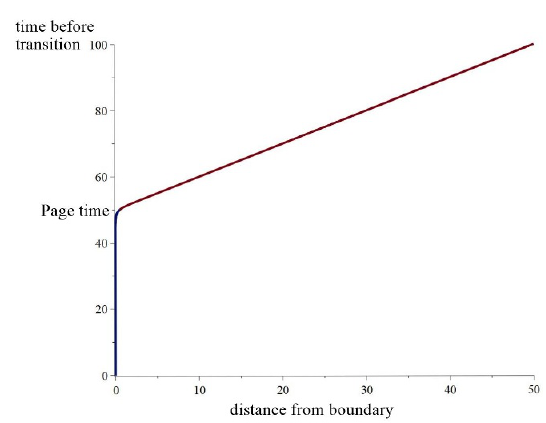
Figure 2 . Time at which the subsystem of the radiation system greater than some distance from the BCFT boundary exhibits a transition in its entanglement entropy, for the case c bnd =c bulk (cid:24) 50. After the transition, the entanglement wedge of this subset of the radiation system includes a portion of the black hole interior. After a time equal to the Page time plus the light travel time from the boundary to our subsystem, there is enough information in the subsystem to reconstruct part of the black